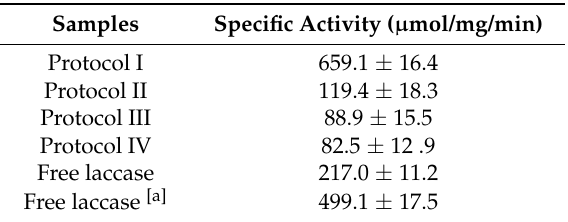
Table 1. The specific activity of entrapped laccase with different protocols.